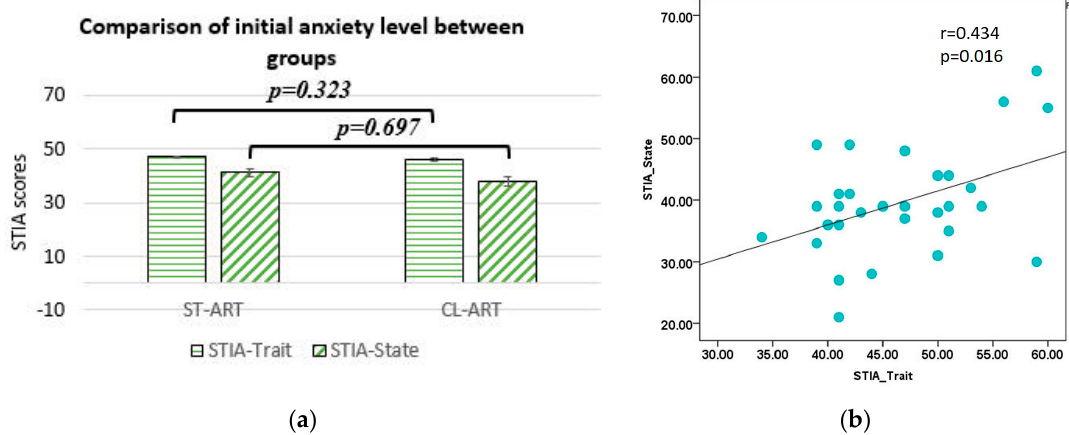
Figure 2. ( a ) One-way ANOVA analysis of state and trait anxiety State-Trait Anxiety Inventory questionnaire (STAI) scores between ST-ART and CL-ART groups; ( b ) scatter plots for state and trait anxiety STAI scores.